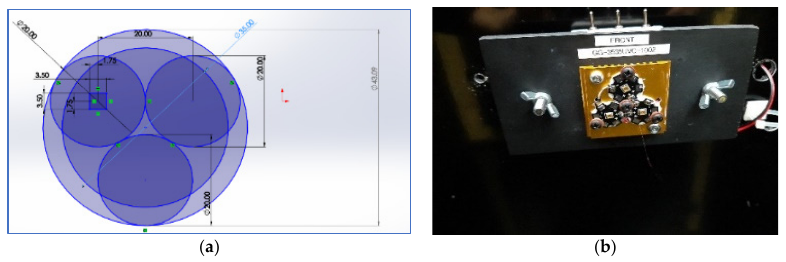
Figure 2. The CAD model and overall LED setup: ( a ) the three LED modules were connected in a three ‐ corner arrangement to form a UVC LED system; ( b ) final UVC PCB board with a toggle switch.